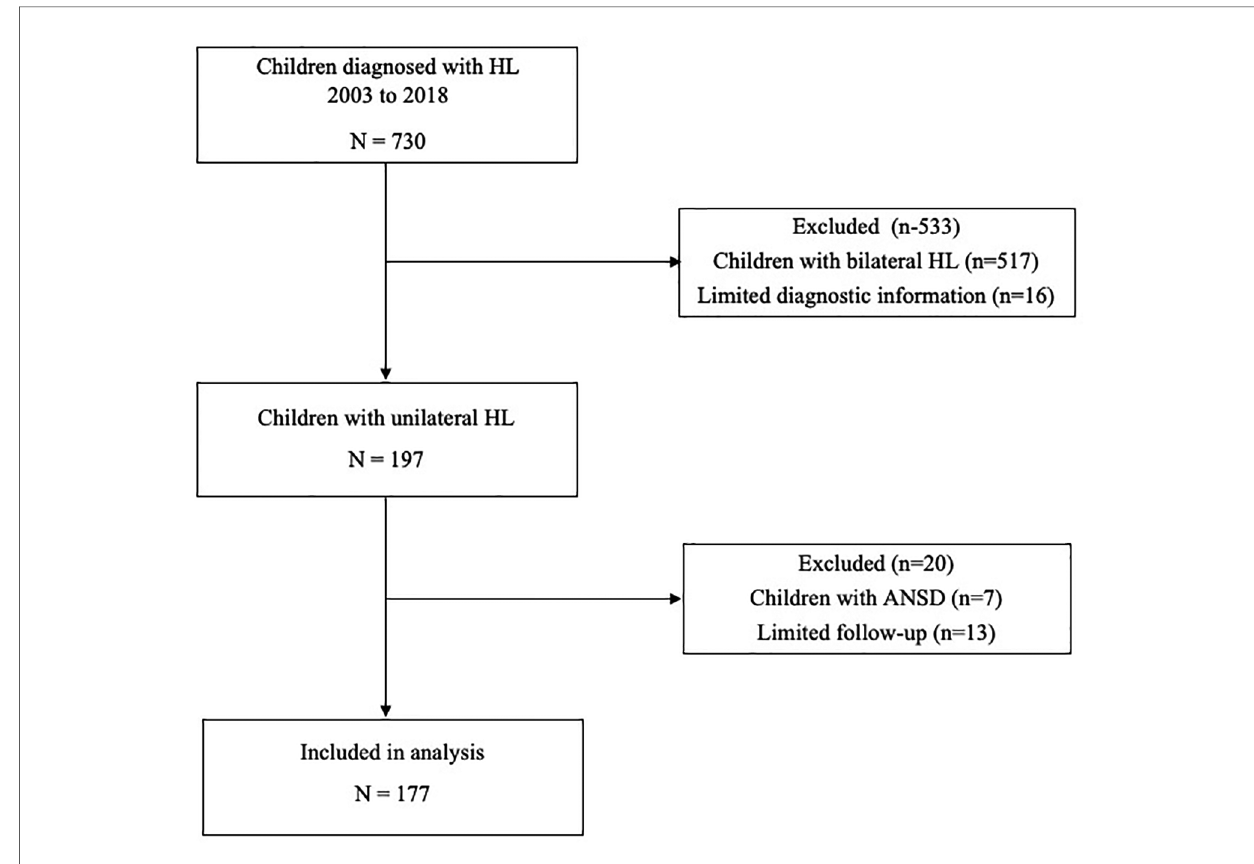
FIGURE 1 Selection of study participants. ANSD, auditory neuropathy spectrum disorder; HL, hearing